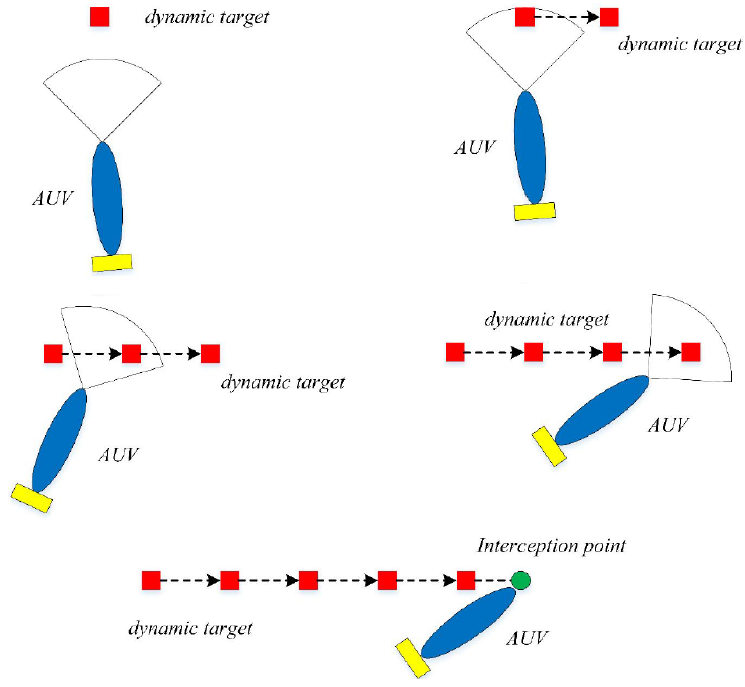
Figure 9. The interception process.